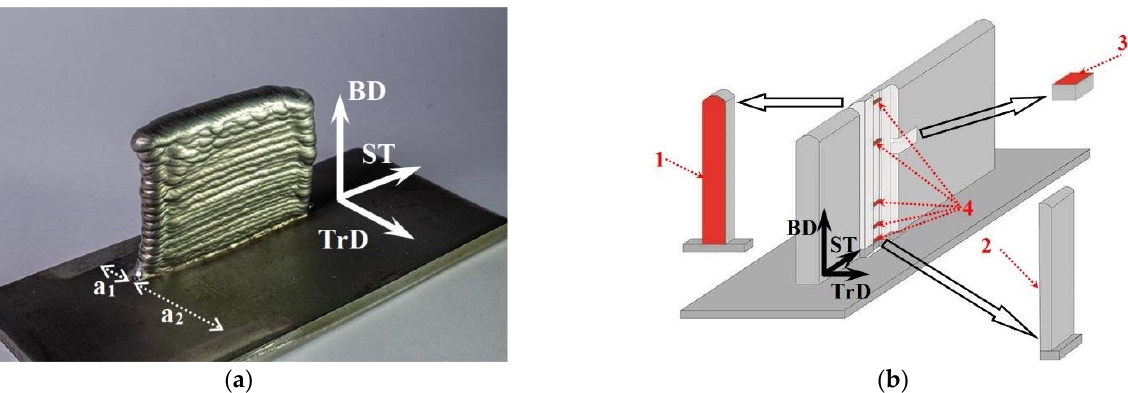
Figure 2. General view of products obtained by wire-feed electron beam additive manufacturing ( a ) and schematic view of specimens cut out for structural studies ( b ). Metallographic studies were carried out on prepared surface 1. Metallographic and SEM studies were carried out on prepared surface 2. X-ray studies were conducted on surface 3. TEM and SEM studies were conducted on surface 4. BD — building direction, ST — scanning trajectory, TrD — transverse direction.